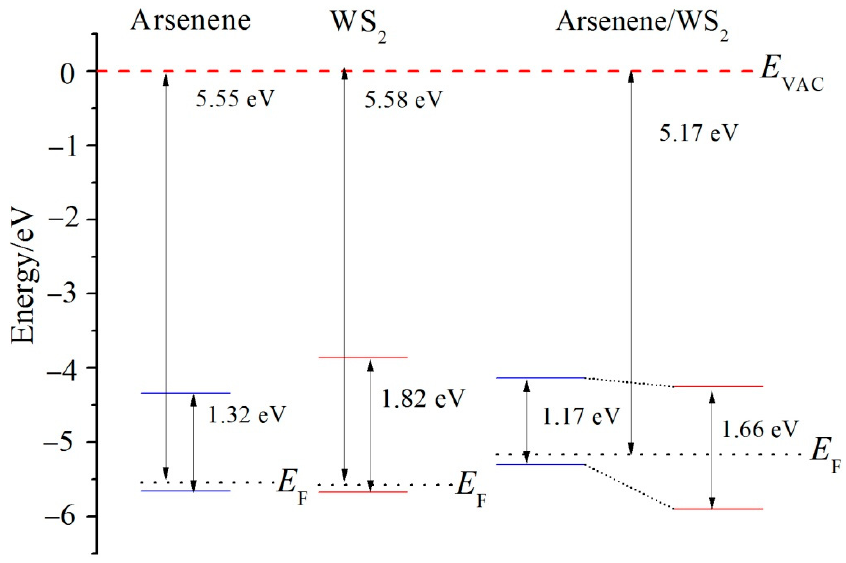
Figure 3. The band alignment of monolayers and the arsenene/WS 2 heterostructure.